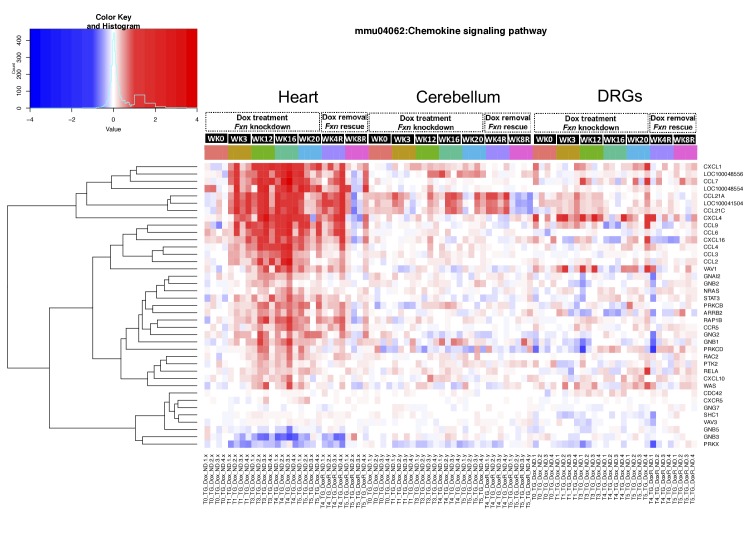
Chemokine signaling pathway is altered in frataxin knockdown mice.Gene expression differences in chemokine signaling pathway from mice with frataxin knockdown and rescue is shown. Heatmap showing differentially expressed genes (relative log two fold change) in chemokine signaling pathway (KEGG: mmu04062) from heart, cerebellum and DRGs tissue of Tg + mice at 0, 3, 12, 16, 20 and plus 4, 8 weeks post dox treatment relative to controls.